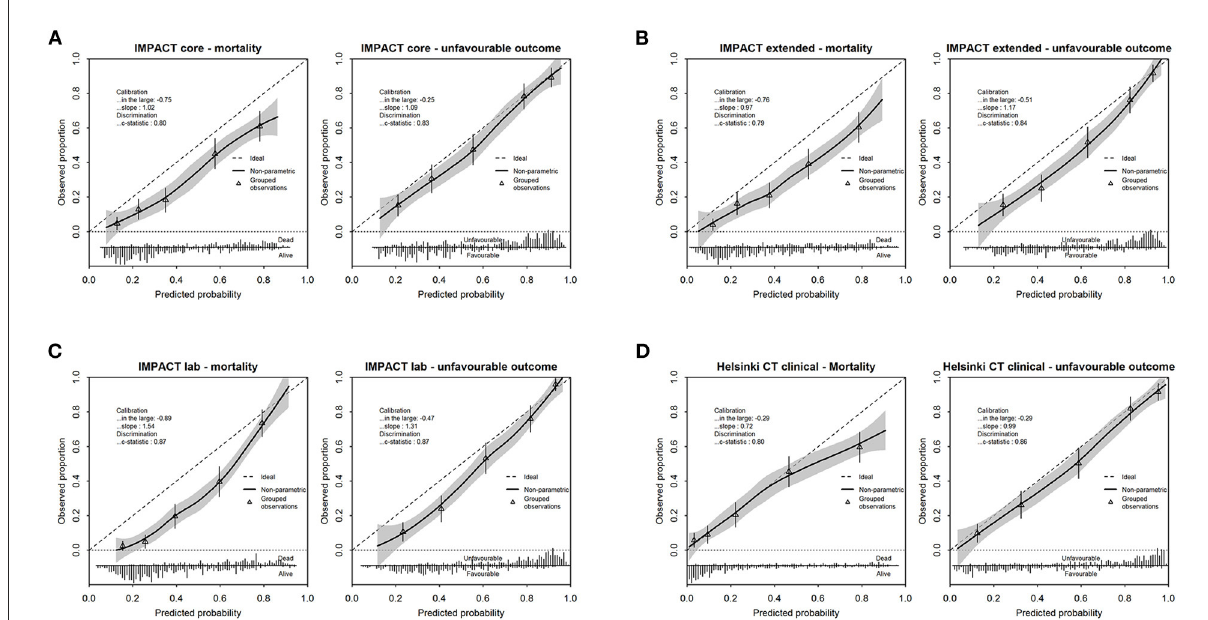
FIGURE2 Calibration plots depicting observed vs. predicted outcome for mortality and unfavorable outcome for the IMPACT models [core model (A) , extended model (B) , lab model (C) ] and Helsinki CT clinical model (D) . Performance parameters (calibration in the large, slope and c-statistic) are displayed in each calibration plot. The frequencies of predicted probabilities, differentiated for the observed outcome of interest, is presented in the lower bar graph.